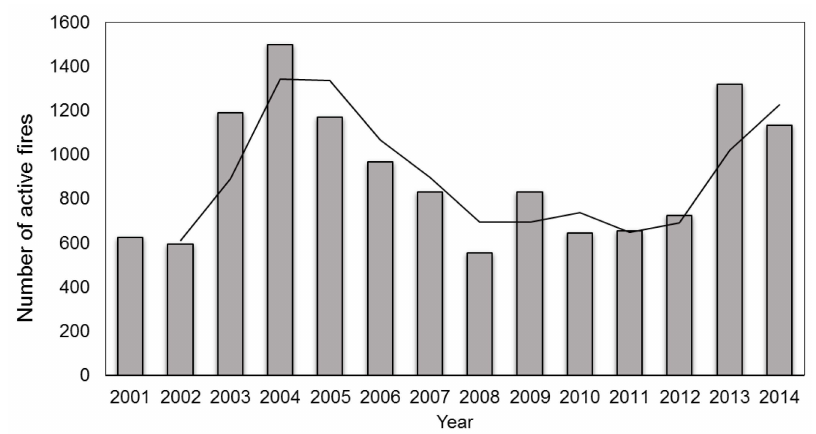
Figure 4. Number of satellite detected active fires per year in El Salvador between 2001 and 2014. The line shows a running average for the average annual values across the study time period.